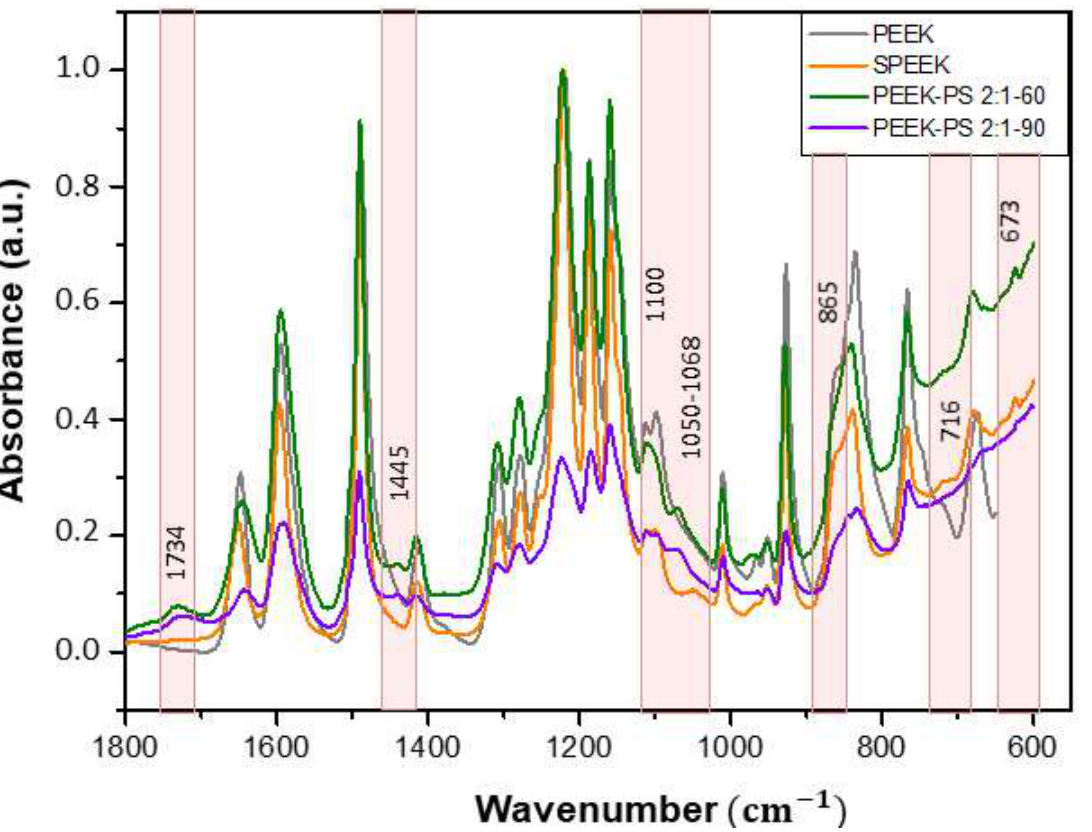
Figure 7. Comparative FTIR spectra of PEEK, SPEEK 90, PEEK-PS 2:1-60, and PEEK-PS 2:1-90, showing an enlargement of the region of 1800 to 550 cm −1 .